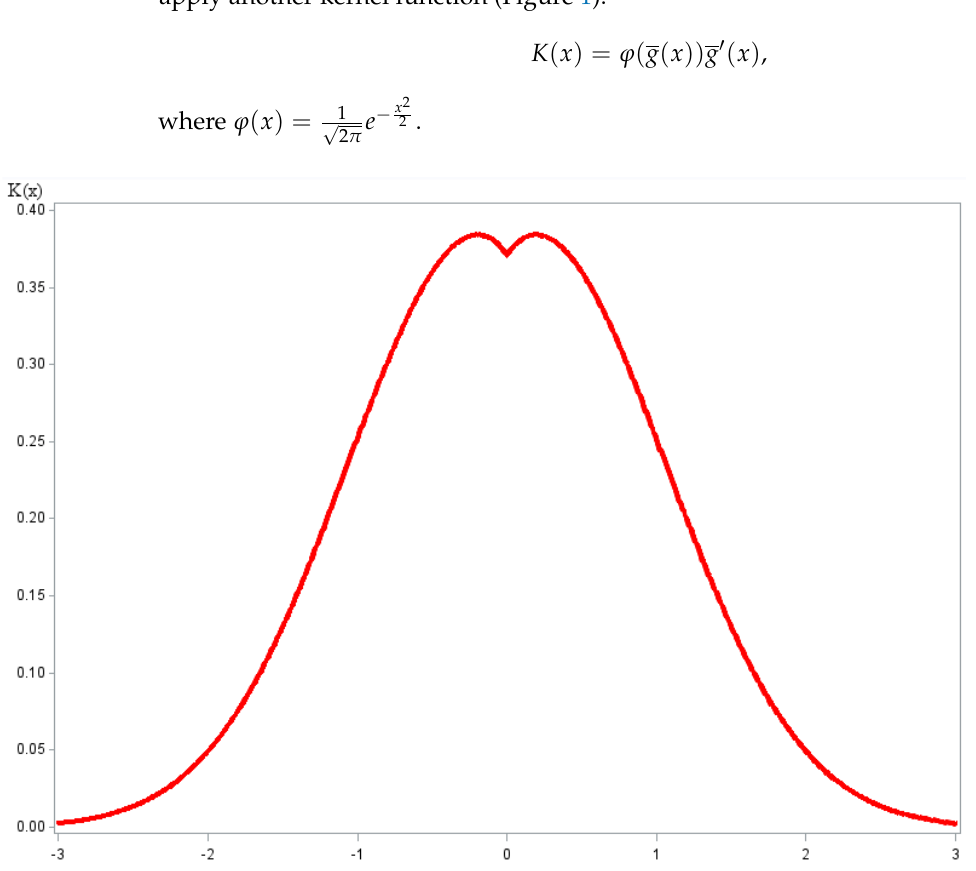
Figure 1. Plot of out kernel function K ( x ) with experimentally chosen optimal parameters a = 0.95, b = 0.25, and c = 1.